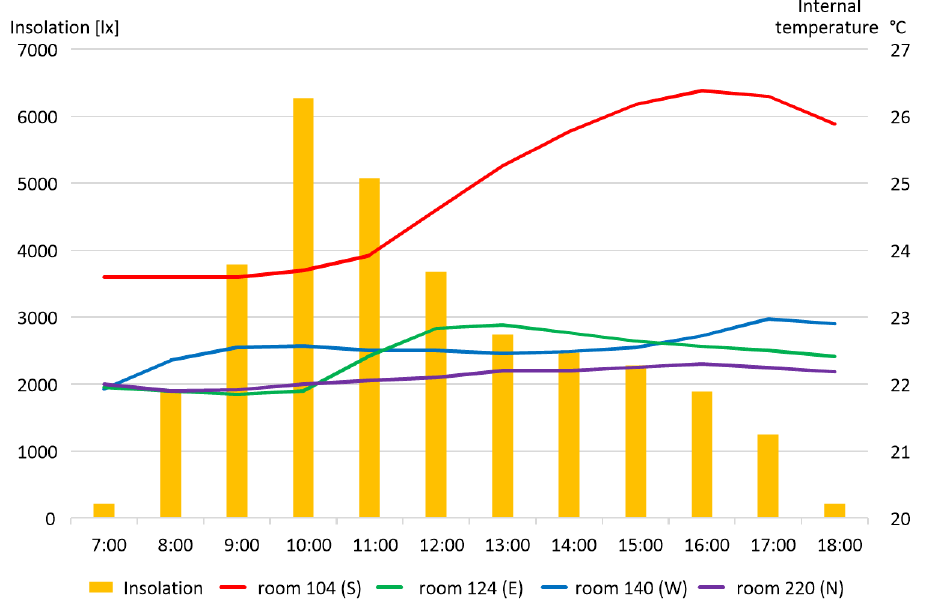
Figure 14. Dependence of internal temperature for rooms 104, 124, and 140 on insolation during sun radiation exposure in comparison to internal temperature for room 220.